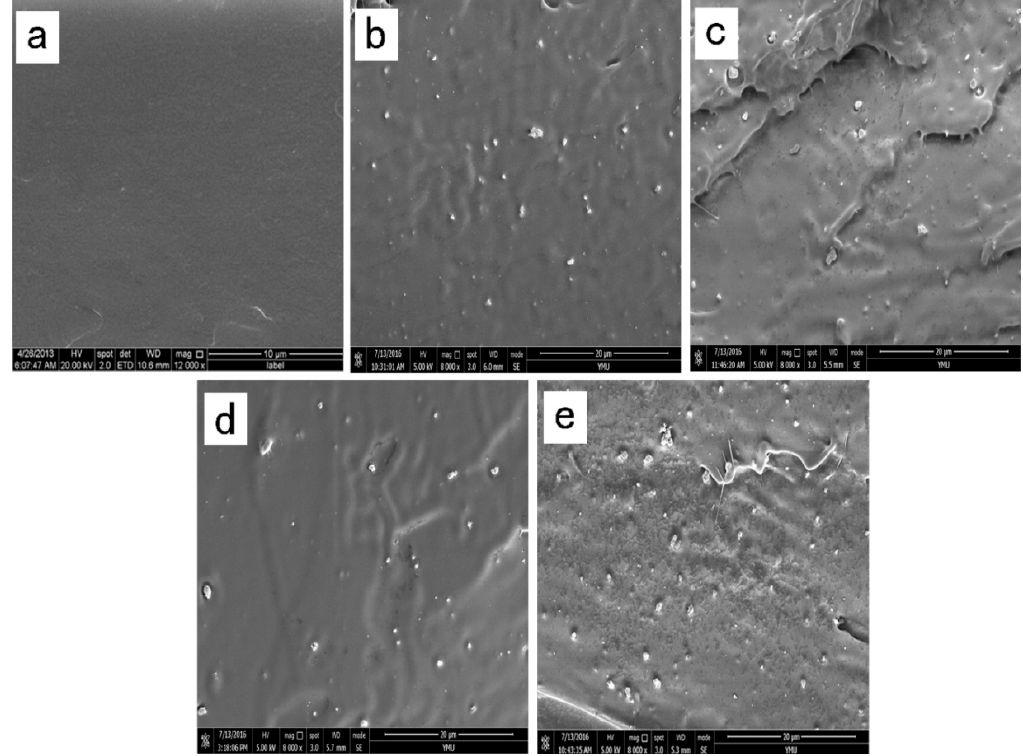
Figure 3. SEM micrographs of the fracture morphology of: ( a ) PLA, ( b ) PLA/Ti1%, ( c ) PLA/Ti5%, ( d ) PLA/Ti1%/Ag, and ( e ) PLA/Ti5%/Ag.